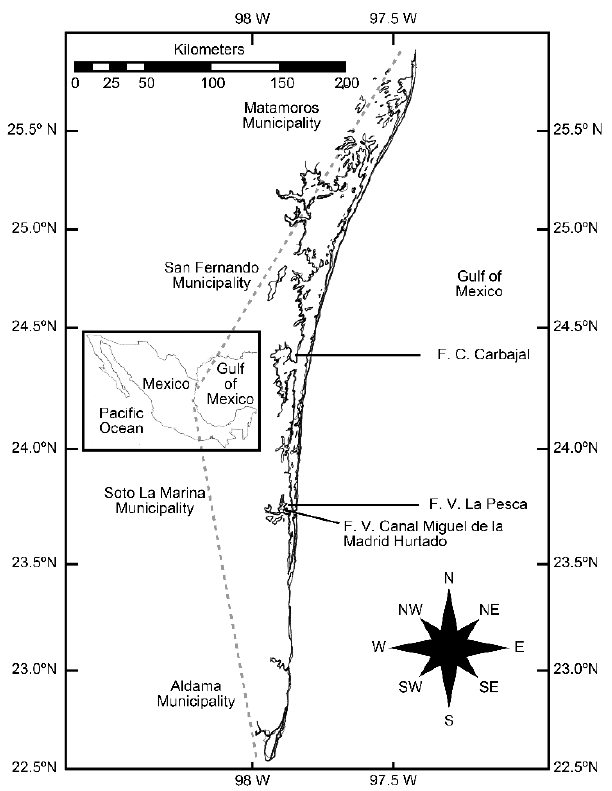
Figure 1. Sampling sites of the bonnethead shark Sphyrna tiburo in the western Gulf of Mexico.